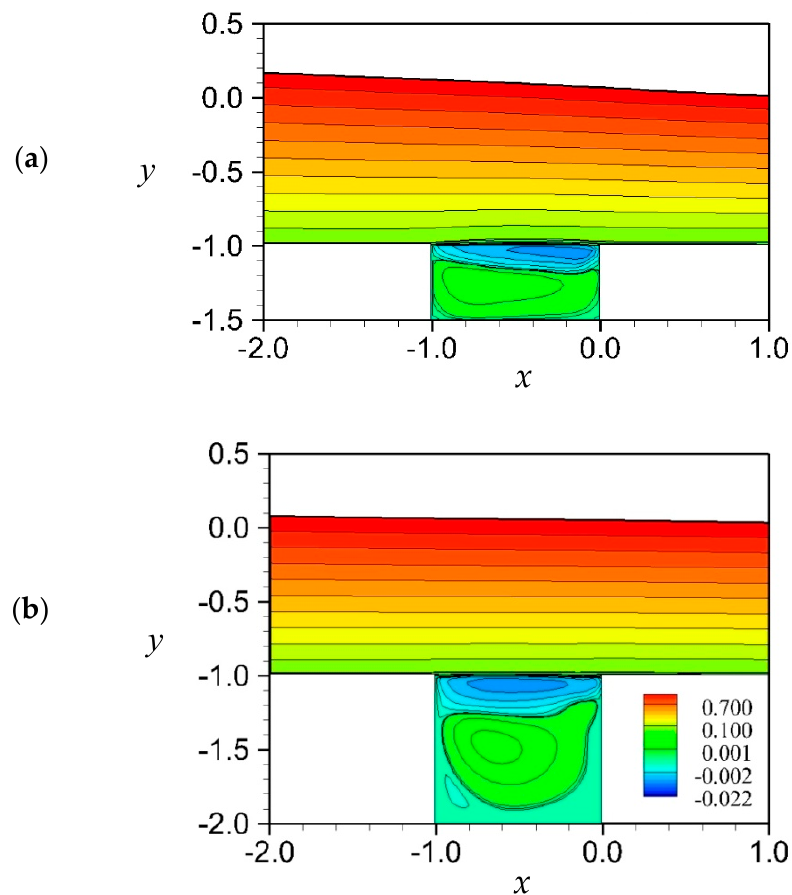
Figure 16. Streamline patterns in a cavity for Re = 5000 and Fr = 1.0 at t = 300 (quasi- steady phase) with cavity size ( a ) 1.0 × 0.5, and ( b ) 1.0 × 1.0.